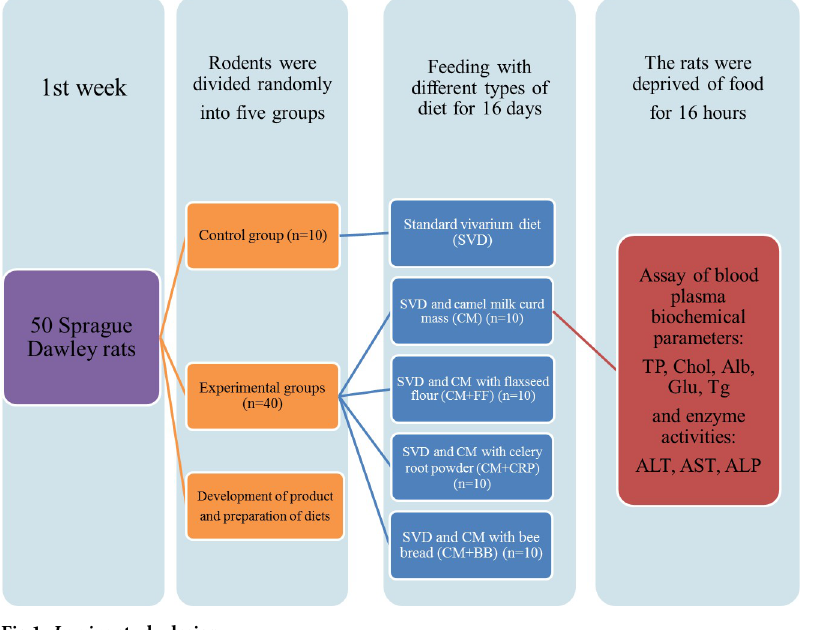
Fig 1. In-vivo study design.